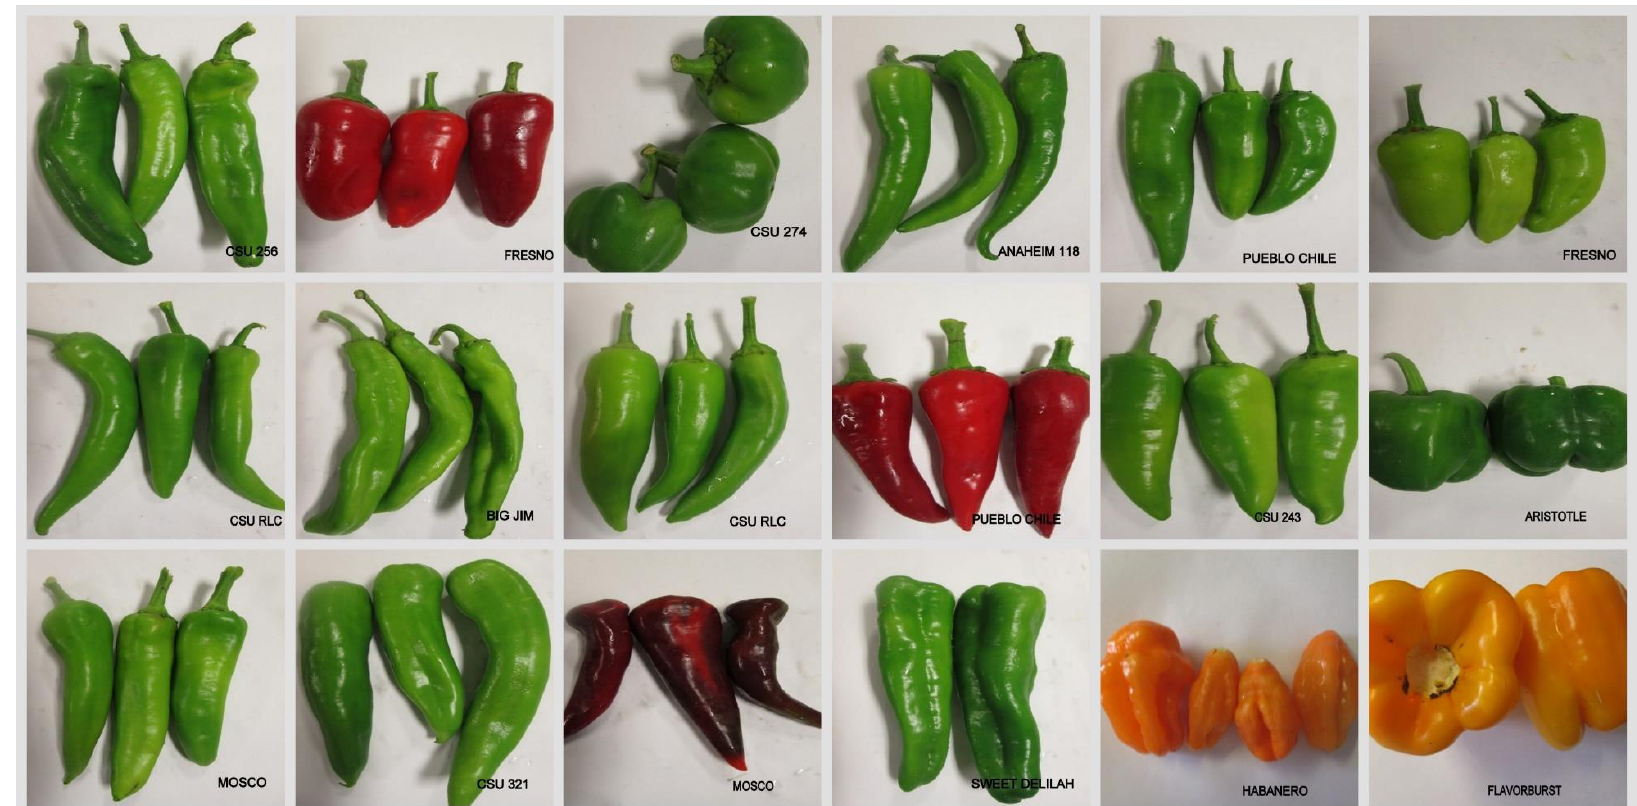
Figure 1. Morphological diversity of pepper pods of selected cultivars developed and grown at Arkansas Valley Research Center, Rocky Ford. All cultivars belong to C. annuum species except Habanero which is a C. chinense .